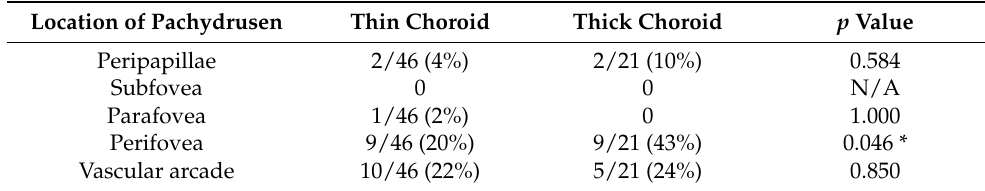
Table 3. Presence of pachydrusens in PCV eyes according to location stratified by choroidal thickness.